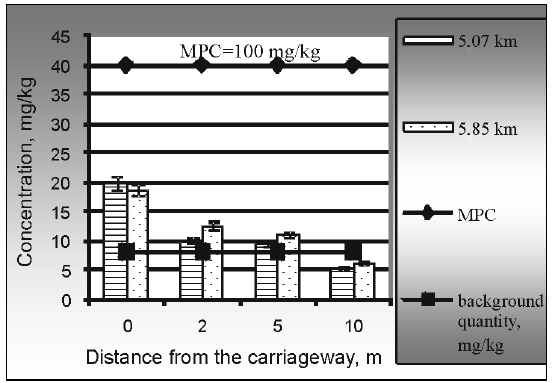
Fig. 9. Copper concentration in the roadside soil of the